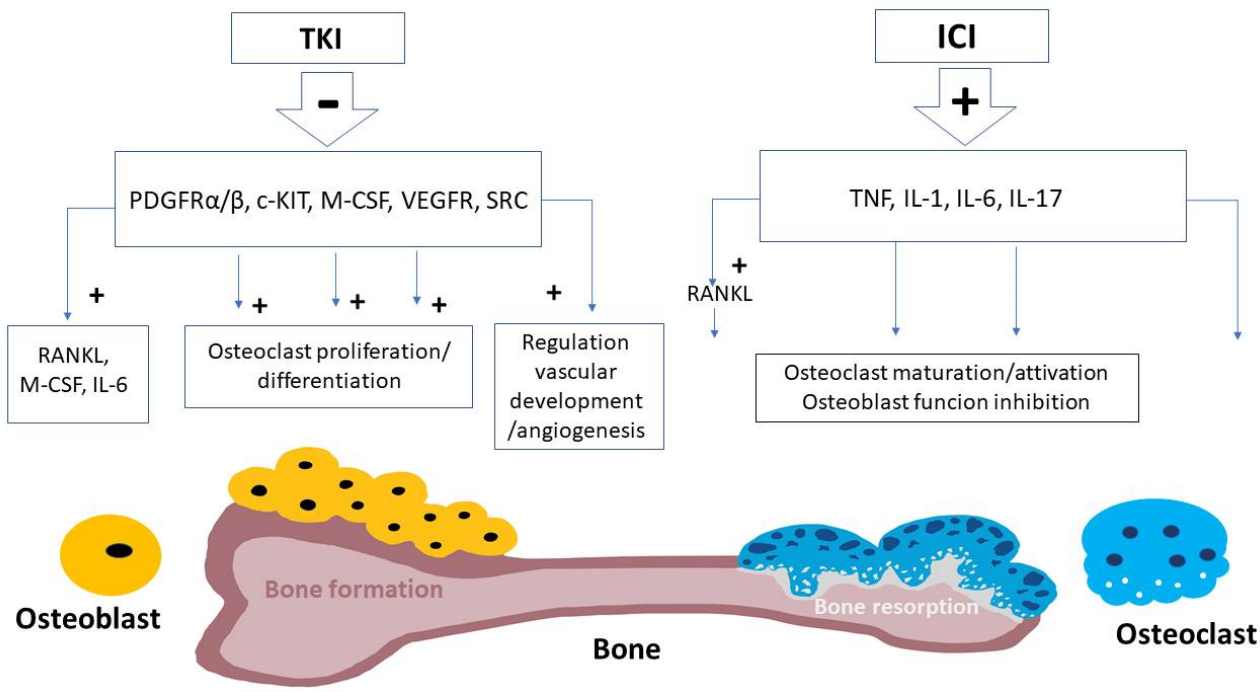
Figure 1. Schematic mechanisms of bone remodeling induced by tyrosine kinase inhibitors and immune checkpoint inhibitors. Tyrosine kinase inhibitors (TKI) cause the inhibition of various receptor kinases of bone cells, negatively affecting osteoclast proliferation/differentiation and regulation of vascular development and angiogenesis (see text) [61–68]. Immune checkpoint inhibitors (ICI) are suggested to mediate their bone effects, in terms of bone resorption, through the stimulation of pro-inflammatory cytokines, including tumor necrosis factor (TNF) and various interleukins (i.e., IL-1, IL-6, and IL-17) [69–75].